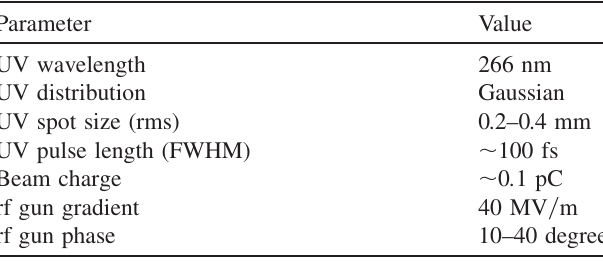
TABLE II. Thermal emittance experiment settings.